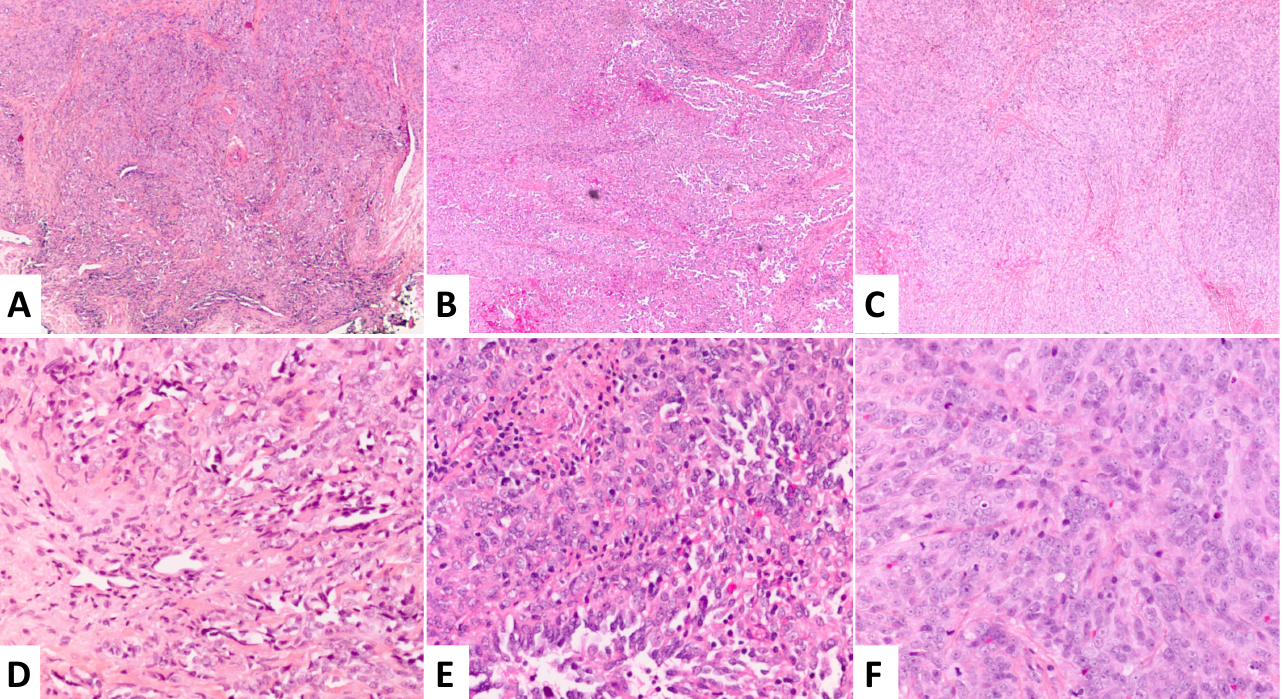
Figure 2. Immunohistochemical stains of the second lesion (2015) at 100× magnification. 3. Discussion CHE can present as a nodule, plaque, or ulcerated tumor, with a size ranging from 0.4 to 30 cm. They are found predominantly in the dermis and subcutis of the distal ex- tremities. The other locations include the head and neck, paraspinal region, gluteal region, kidney, spleen, retroperitoneum, and mediastinum [1,3–9]. This is the first reported case of this entity occurring in the penile region. CHE rarely metastasizes, but it has a high local recurrence rate, with the time to recurrence ranging from 4 months to 10 years after